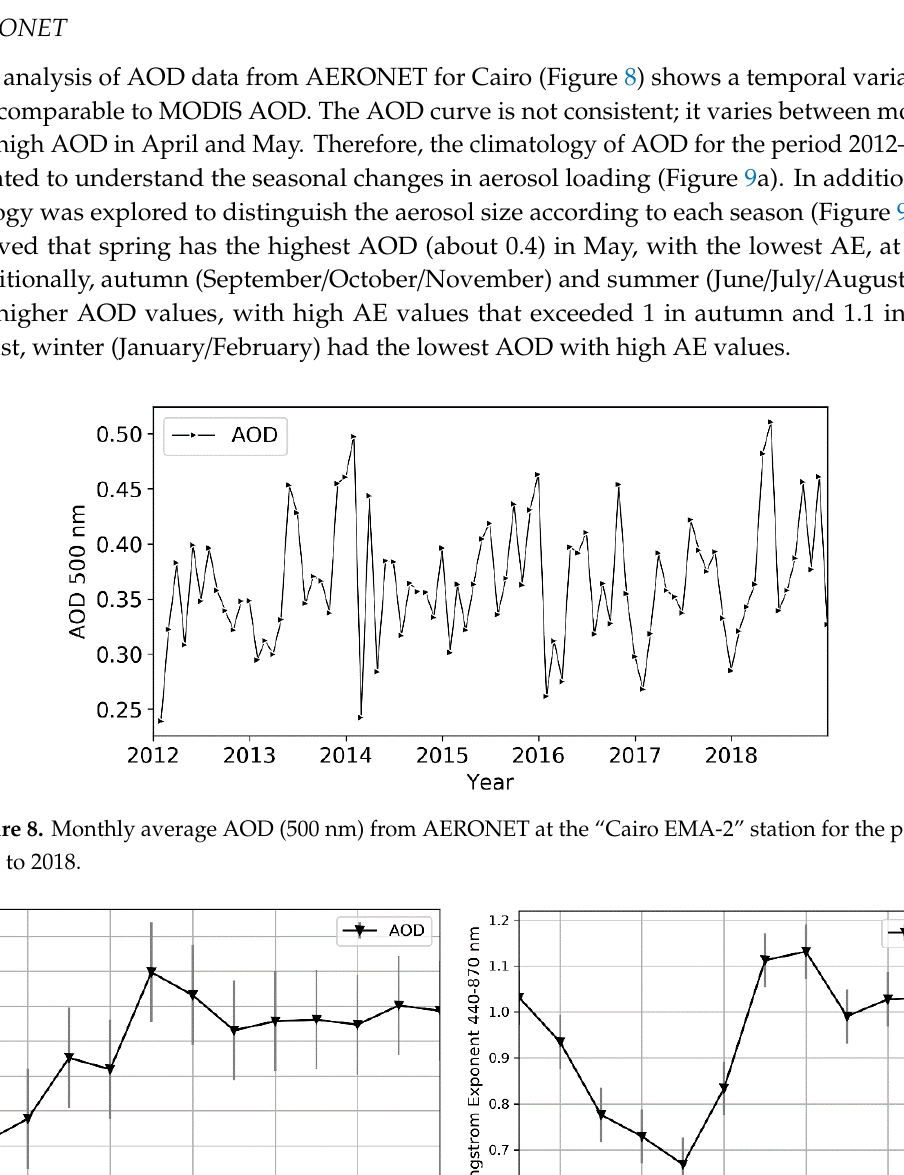
Figure 7. Seasonal variations of AOD over Egypt using level 3 combined Dark Target (DT) and Deep Blue (DB) MODIS Terra data at 550 nm; data are averaged for winter (DJF), spring (MAM), summer